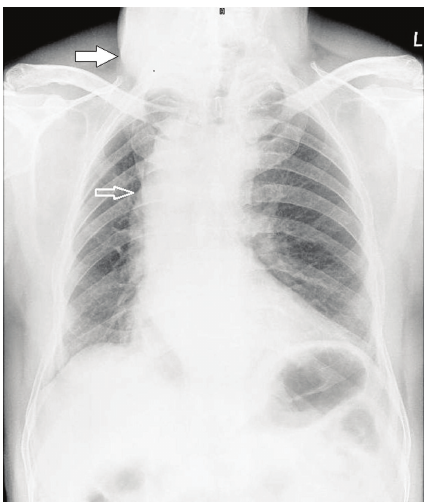
Figure 1: Frontal chest radiograph shows evidence of right-sided aortic arch (open arrow) and also a soft-tissue density in the neck representing thyromegaly (solid arrow).